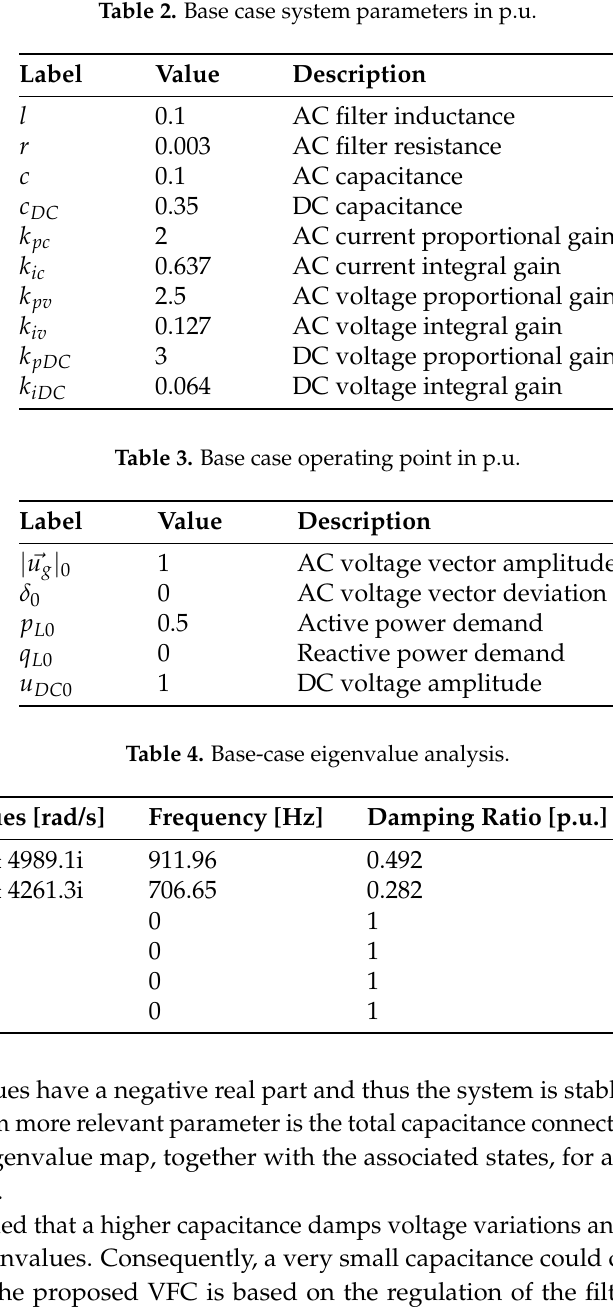
Table 2. Base case system parameters in p.u.